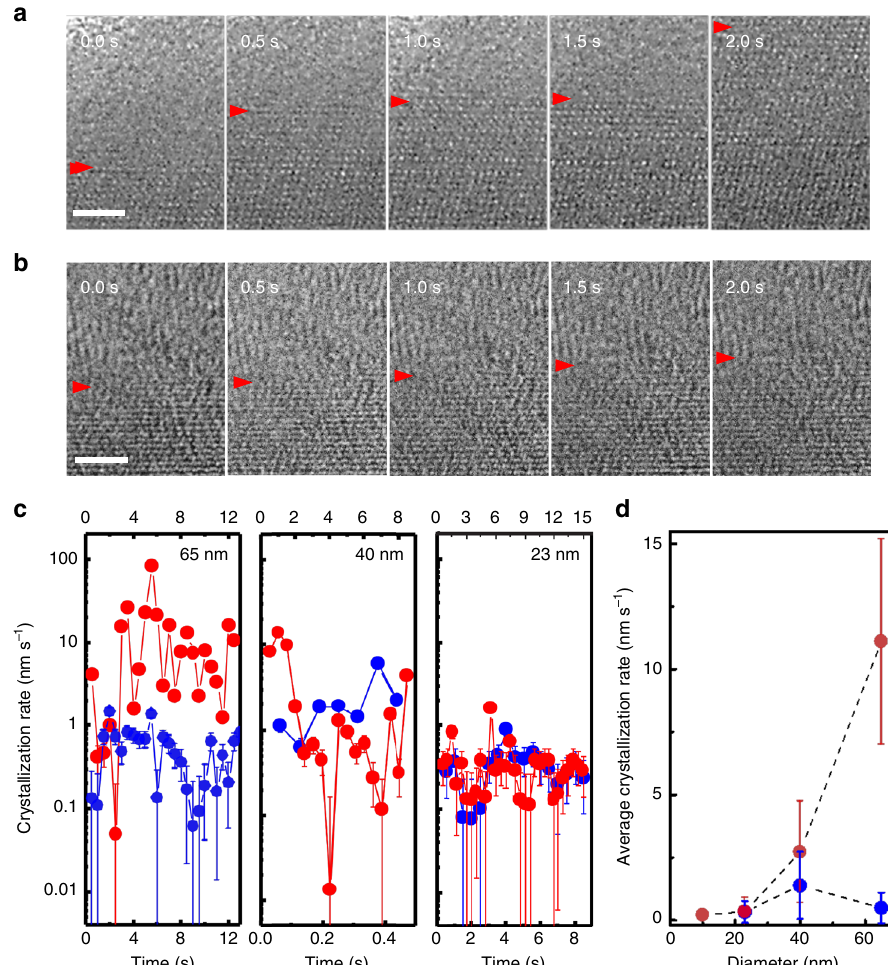
Fig. 3 Asymmetric growth rates of MG nanorods of different diameters. a TEM snapshots from the in situ TEM movie of a 65 nm MG nanorod upon rapid heating from the glass (30 °C) to the crystallization temperature (360 °C). b TEM snapshots from the in situ TEM movie of the same 65 nm MG nanorod upon rapid quenching from the melt (900 °C) to the crystallization temperature (360 °C). Red arrows mark the growth front, measured by the intensity pro fi les similar to the one shown in Fig. 2c. The scale bars are 2 nm. c Time-resolved growth rates of nanorods of different diameters for two crystallizations: one from the heated glass (red dots, top x -axis) and the other from the cooled melt (blue dots, bottom x -axis). Three MG rods of different diameters (65 nm (left), 40 nm (middle), and 23 nm (right)) were investigated. The growth rate was measured along the perpendicular direction to the (200) crystallographic plane. The temporal resolution of the growth rate is 0.5 s except for the 40 nm rod from the melt to 360 °C. For the cooling experiment of the 40 nm rod, the growth dynamics was tracked for only a short time. In this case, the images were not averaged over 200 frames. The asymmetry between the growth rates upon heating and cooling gradually disappears with decreasing MG rod diameter. The error bars represent ±0.15 nm. d Average growth rate as a function of the MG rod diameter. The vanishing difference in the growth rate with decreasing rod diameter is clear. The error bars represent the standard deviation of the growth